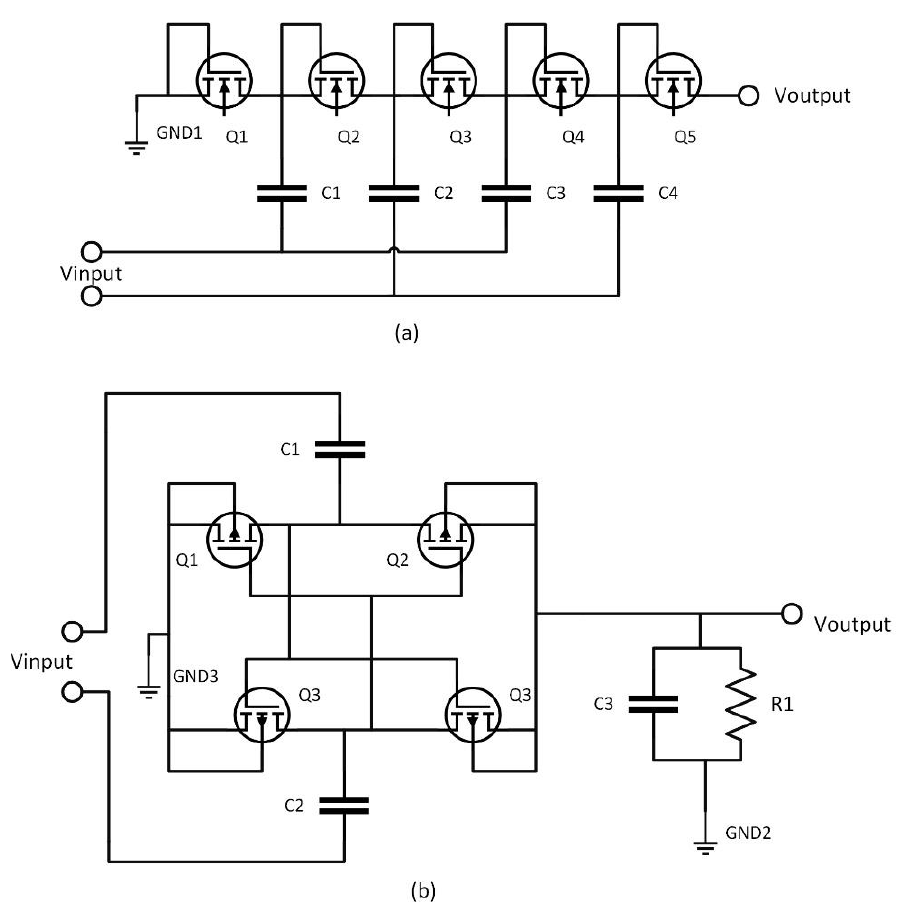
Figure 10. CMOS rectifier topologies: ( a ) Dickson Charge Pump ( b ) Differential Voltage Multi- plier.